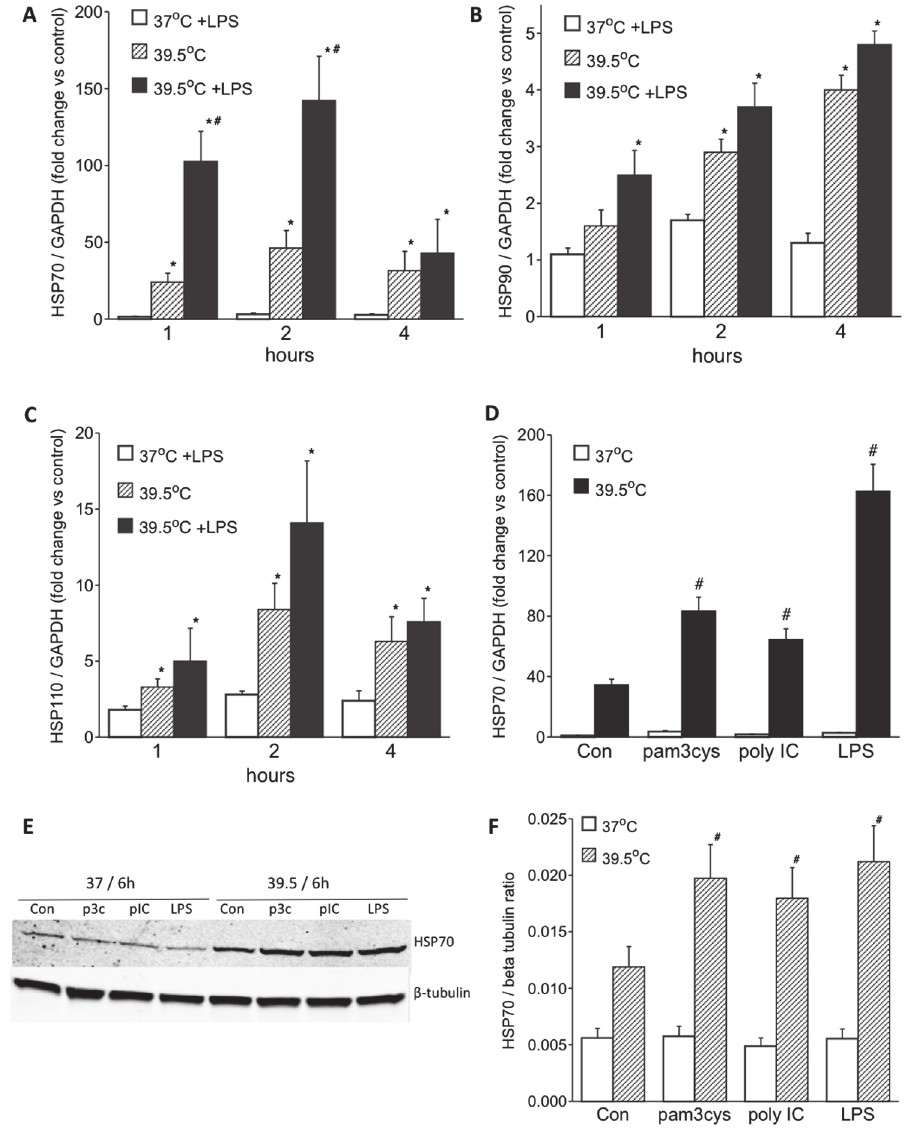
Fig 1. TLR agonists enhance FRH-induced HSP70 expression in THP1 cells : A – C. Differentiated THP1 cells were stimulated with 100 ng/ml LPS at 37°C or 39.5°C for 1, 2 or 4 h, and HSP70 (HSPA1A) (A), HSP90 (HSP90AA1) (B), and HSP110 (HSPH1) (C) mRNA levels were measured by qPCR, normalized to GAPDH, and expressed as fold change vs. levels in 37°C untreated controls. D. Differentiated THP1 cells were incubated with 0.5 μ g/ml Pam3CSK4, 12.5 μ g/ml poly IC, or 100 ng/ml LPS for 2 h and HSP70 mRNA levels measured. E. Differentiated THP1 cells were incubated with 0.5 μ g/ml Pam3cys (p3c), 12.5 μ g/ml poly IC (p IC), or 100 ng/ml LPS for 6 h at 37°C or 39.5°C and cell lysates were immunoblotted for inducible HSP72 using SPA-812 anti-HSP70 antibody F. The HSP72 band intensites were normalized to ß-tubulin and expressed as fold-change compared with untreated 37°C controls. Data are mean ± SE from 4 independent experiments. * and # denote p < 0.05 vs. 37°C controls and LPS-untreated 39.5°C cells, respectively.